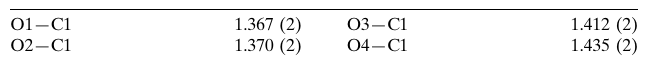
Selected bond lengths (A˚ ).